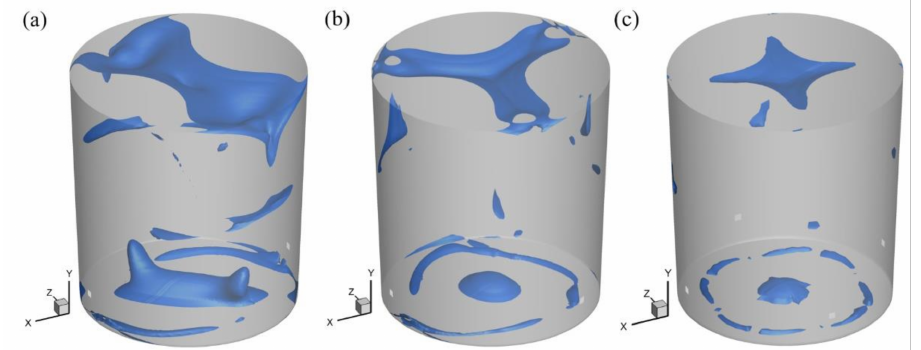
Figure 13. Stagnant regions with different number of side plugs at 116 mm: ( a ) dual side plugs; ( b ) three plugs; ( c ) four side plugs.